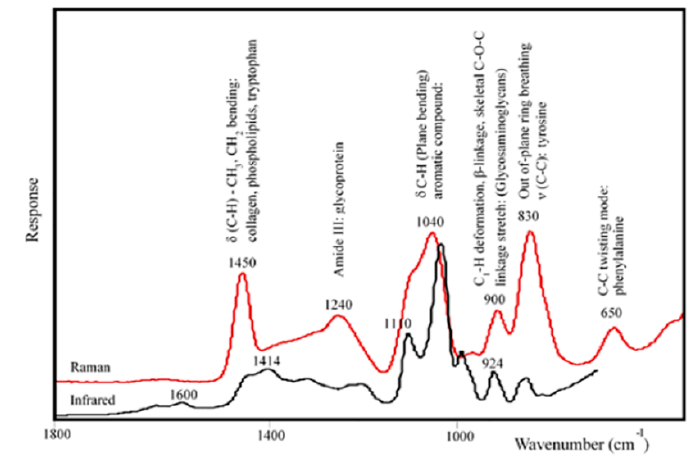
Figure 5. Representative spectra from serum of a subject with Fibromyalgia collected by FT-Raman (red line) and FT-IR (black line) microspectroscopy [39].